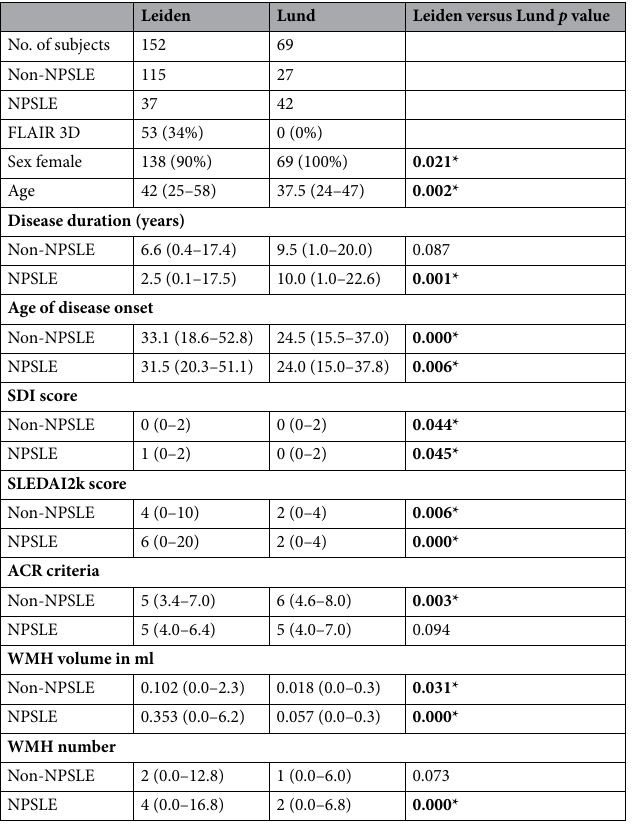
Table 1. Demographic and clinical data across the two site cohorts. Data are represented as number (percentage) or median (10–90 percentile). Differences between Leiden and Lund cohort are expressed in p value and calculated for nominal variables with Chi-square tests (sex) and for continuous variables, based on their not-normally distribution, with Mann–Whitney U tests. Statistical significant values are in [bold]. NPSLE, Neuropsychiatric systemic lupus erythematosus; SDI, Systemic lupus international collaborating clinics damage index; SLEDAI-2K, Systemic lupus erythematosus disease activity index 2000; ACR, American College of Rheumatology. * p value < 0.05.